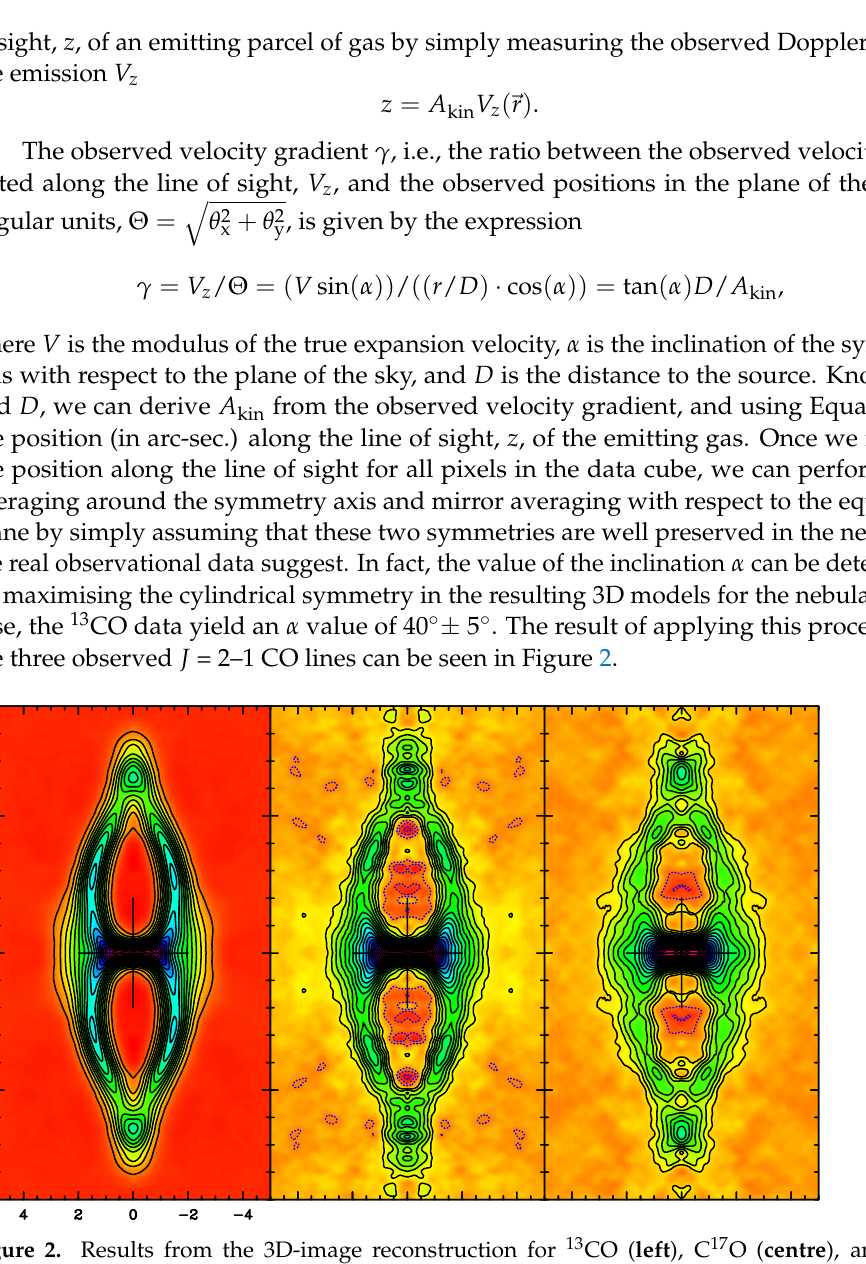
Figure 2. Results from the 3D-image reconstruction for 13 CO ( left ), C 17 O ( centre ), and C 18 O ( right ) J = 2–1 emissions. The plots display the expected brightness distribution of the emission of these lines for a plane containing the symmetry axis of the nebula. Axial and equatorial mirror averaging has also been applied. All maps have been restored using a clean beam of 0. (cid:48)(cid:48) 75 × 0. (cid:48)(cid:48) 75. Con- tour spacing is 650, 62, and 45 mK for 13 CO, C 17 O, and C 18 O, respectively. Note the high similitude between the three maps. The symmetry axis of the nebula is located at the y-axis of each panel. Sizes are given in arc-seconds, equivalent to 3.7 × 10 16 cm for a distance of 2.5kpc. Note that the size of the nebula is larger than in the observed images (see Figure 1) because of the effect of the inclination of the nebula with respect to the plane of the sky has been corrected to show the true size of the object (2.2 × 10 17 cm wide and 6.0 × 10 17 cm